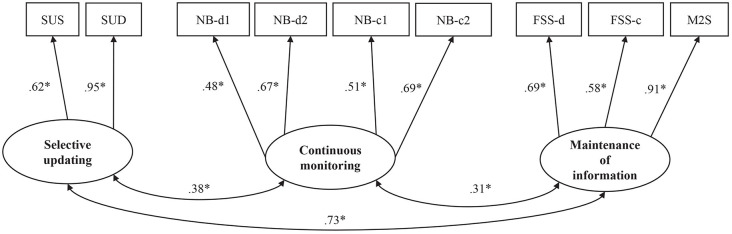
Standardized coefficients for the model of WM, affective symptoms, and everyday cognitive deficits. Latent constructs are shown in ellipses, and observed variables are shown in rectangles. PD, group covariate (1 = PD, 0 = control group); SUS, Selective Updating of Sentences task; SUD, Selective Updating of Digits task; NB-d1, N-back task with digits level 1; NB-d2, N-Back task with digits level 2; NB-c1, N-Back task with colors level 1; NB-c2, N-Back task with colors level 2; FSS-d, Forward Simple Span task with digits; FSS-c, Forward Simple Span task with colors; M2S, Minus 2 Span task; BRIEF-A, Behavior Inventory of Executive Functioning; WMQ, Working Memory Questionnaire; GDS-30, Geriatric Depression Scale-30; LARS, Lille Apathy Rating Scale. *p < 0.05.